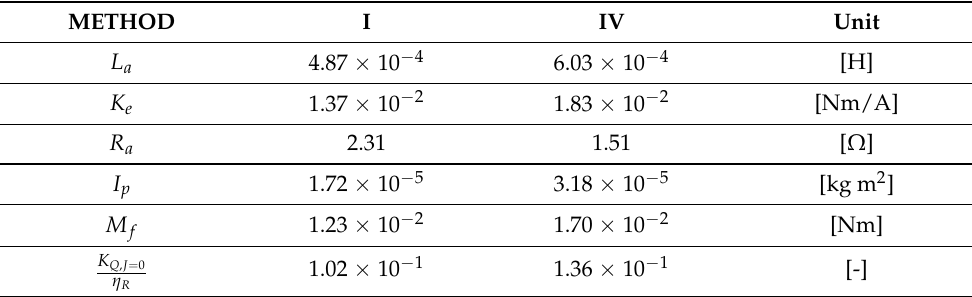
Table 5. Identified